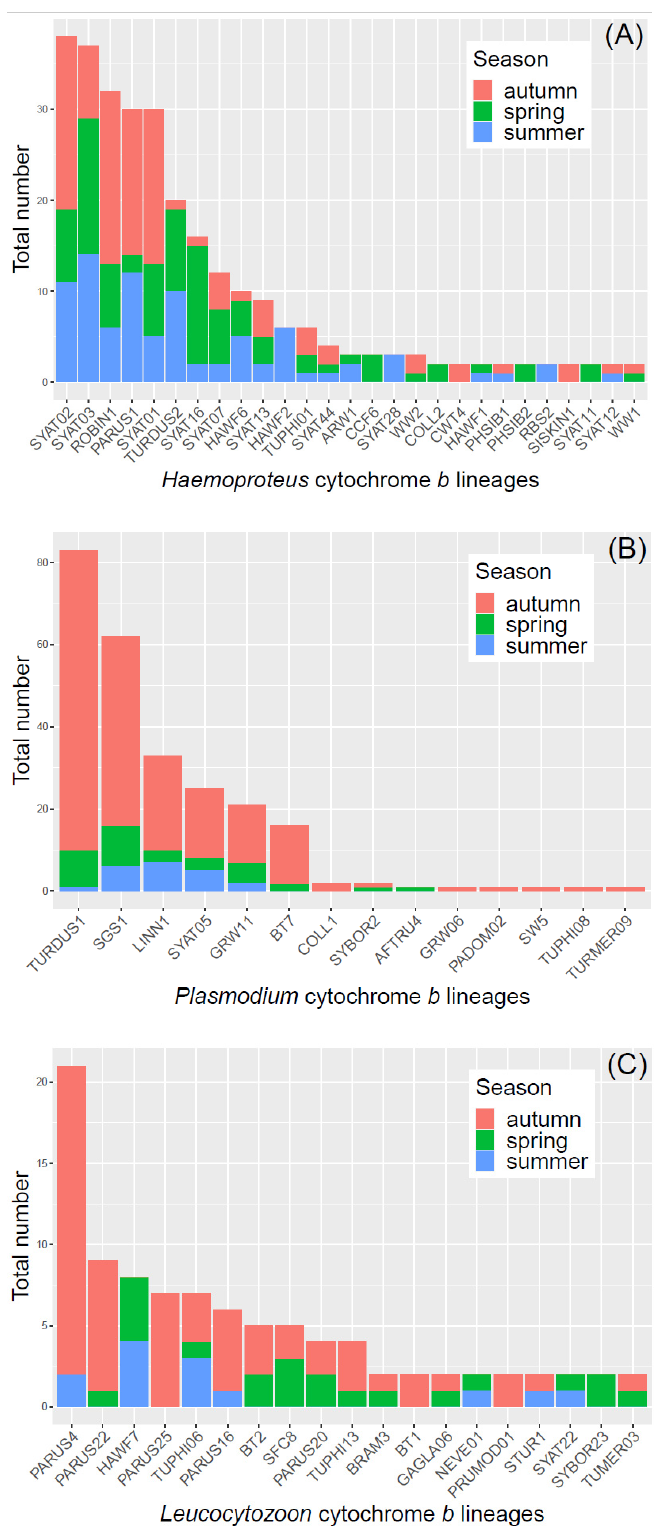
Figure 4. Frequencies of haemosporidian cytochrome b lineages detected in Drienovec, Slovakia, during 2017, 2018 and 2019. Lineage frequencies detected during spring, summer for the genera ( A ) Haemoproteus , ( B ) Plasmodium , and ( C ) Leucocytozoon . For genera Haemoproteus and Leucocytozoon , only lineages detected more than once are shown.